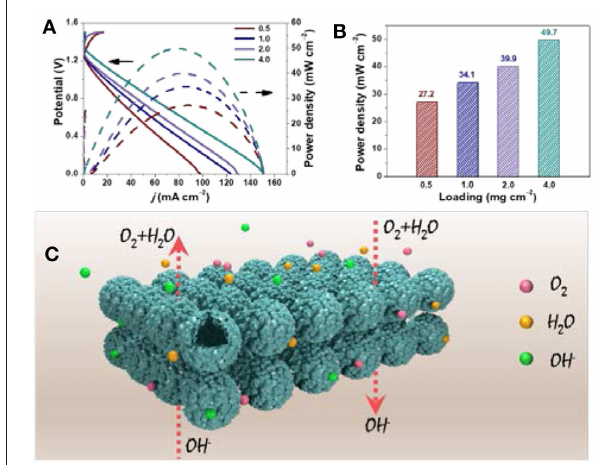
FIGURE 5 | (A) Polarization curves and corresponding power density plots of H-Co/N-C@NiCo 2 O 4 with different mass loading. (B) The histogram of power density vs. mass-loading. (C) Schematic illustration of electrochemical process on H-Co/N-C@NiCo 2 O 4